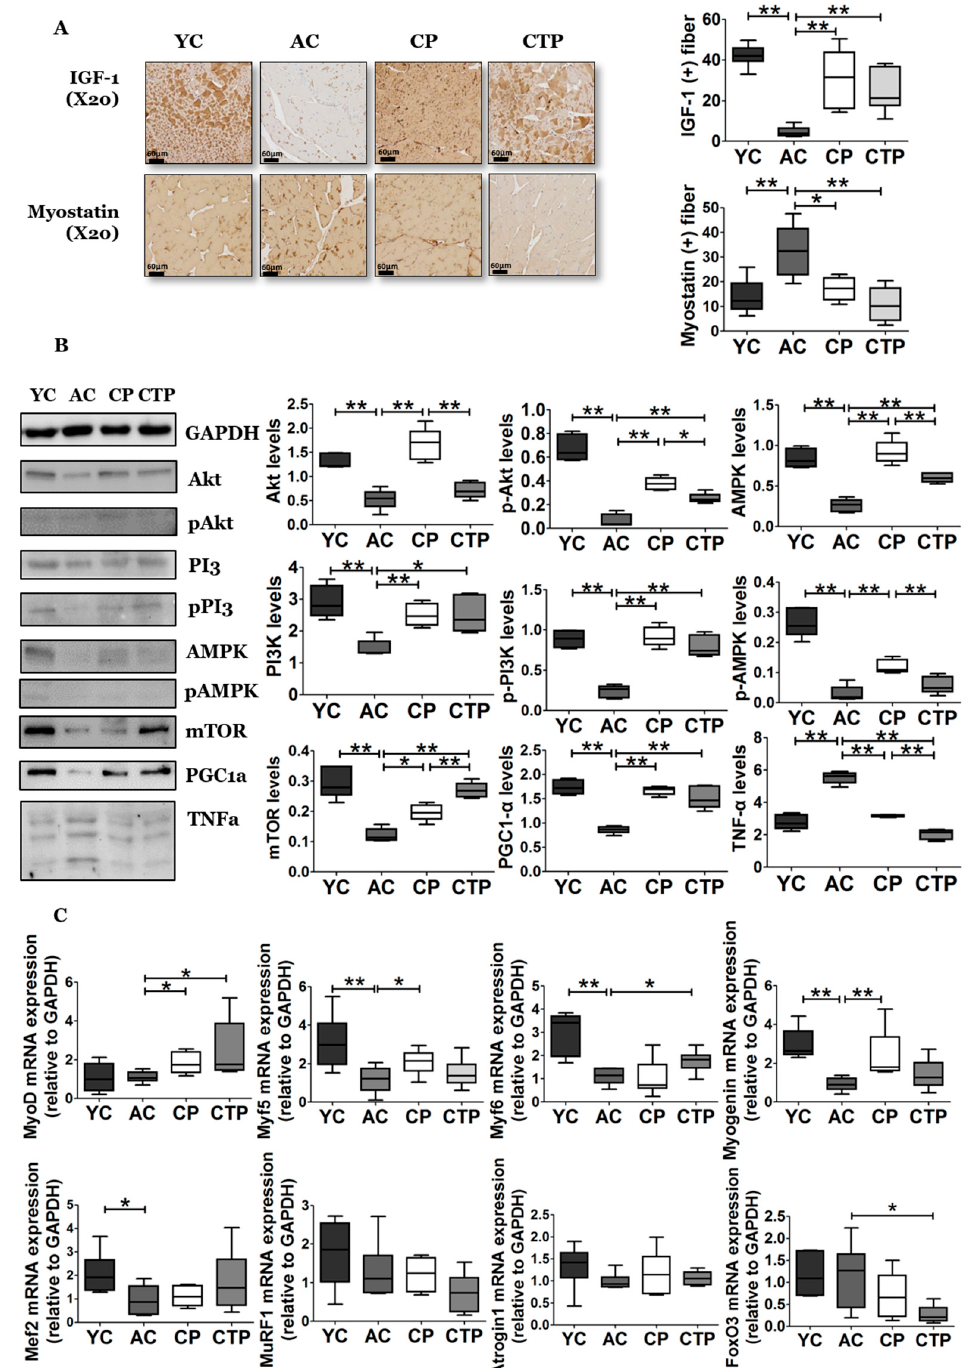
Figure 2. Effect of a 12-week supplementation of CP and CTP on factors related to protein metabolism in the gastrocnemius muscle. ( A ) Immunostaining of the gastrocnemius for insulin-like growth factor 1 (IGF-1) and myostatin. Scale bar = 60 µm. ( B ) Western blot analysis; ( C ) mRNA expression by qRT-PCR. Data are presented as the mean ± SE. Significant differences are indicated as follows: * p < 0.05, and ** p < 0.01. YC, young mice control (12 weeks old, n = 6); AC, aging control (60 weeks old, n = 6); CP, collagen peptide (60 weeks old, n = 6); CTP, collagen tripeptide (60 weeks old, n = 6); MyoD, myoblast determination protein 1; Myf, myogenic factor; Mef, Mouse Embryonic Fibroblasts; MuRF1, muscle RING-finger protein-1; FoxO3, forkhead box O3.